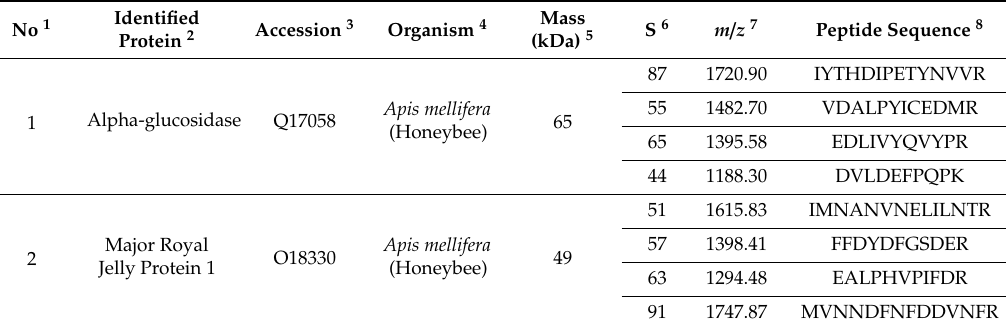
Table 2. The results of MS analysis performed on two selected proteins.